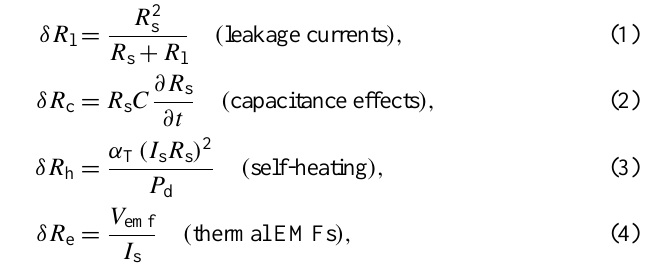
Earth Syst. Sci. Data www.earth-syst-sci-data.net www.earth-syst-sci-data.net